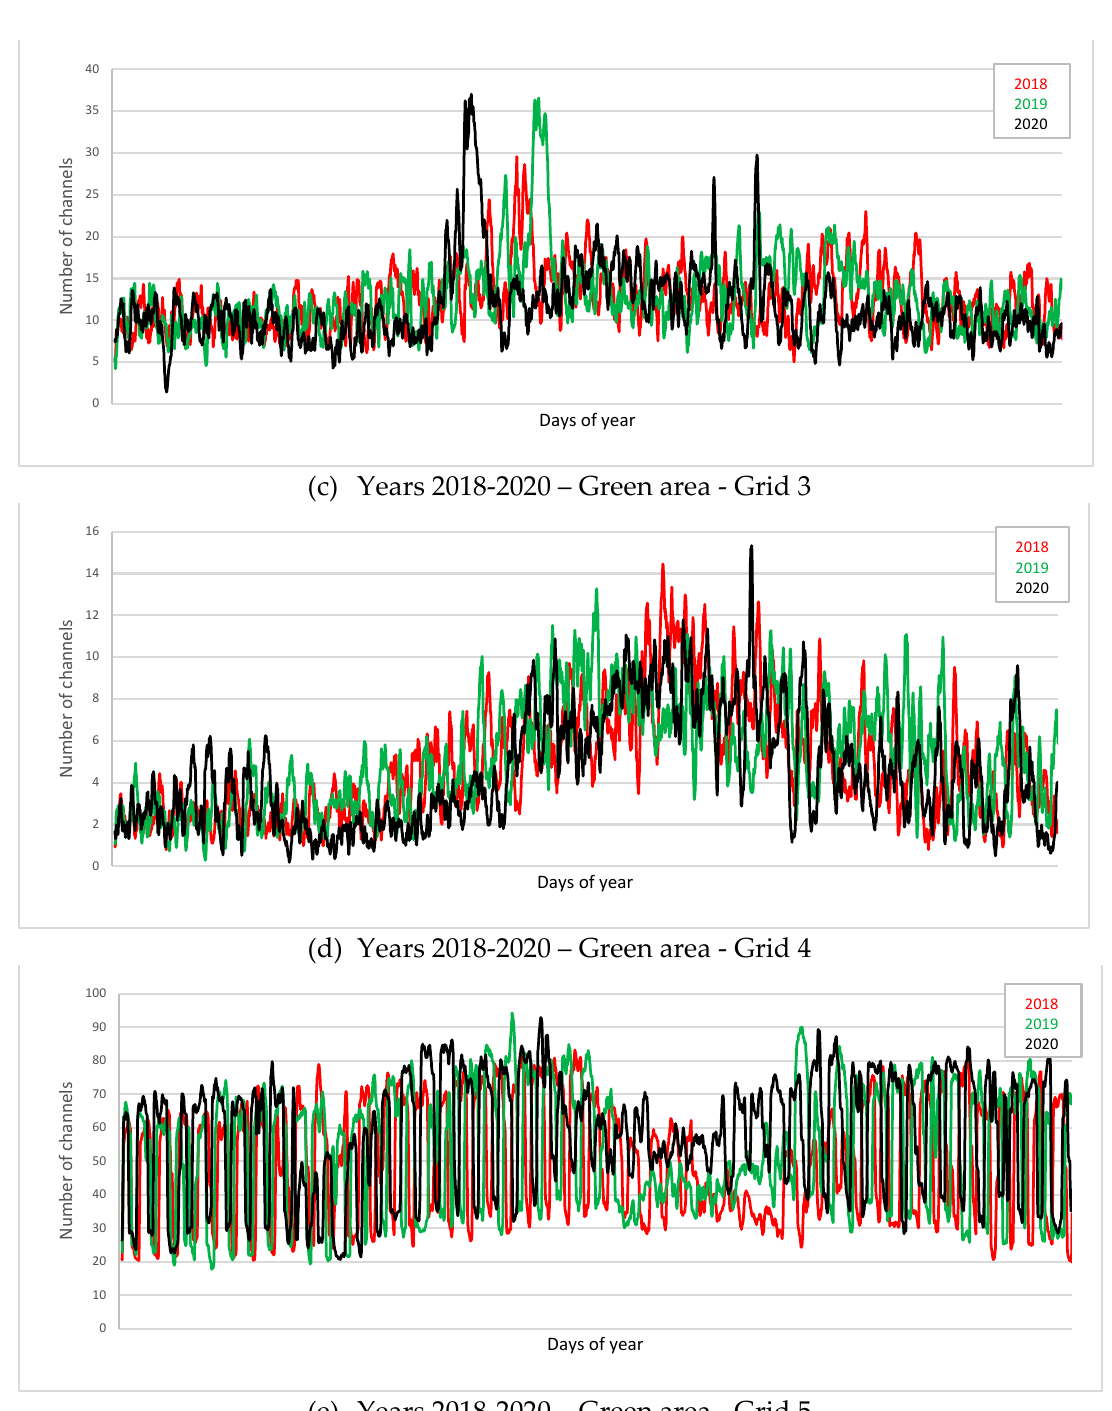
Figure 10. Results corresponding to the number of channels constituted from 2018 to 2020 in the green geographical area under study.